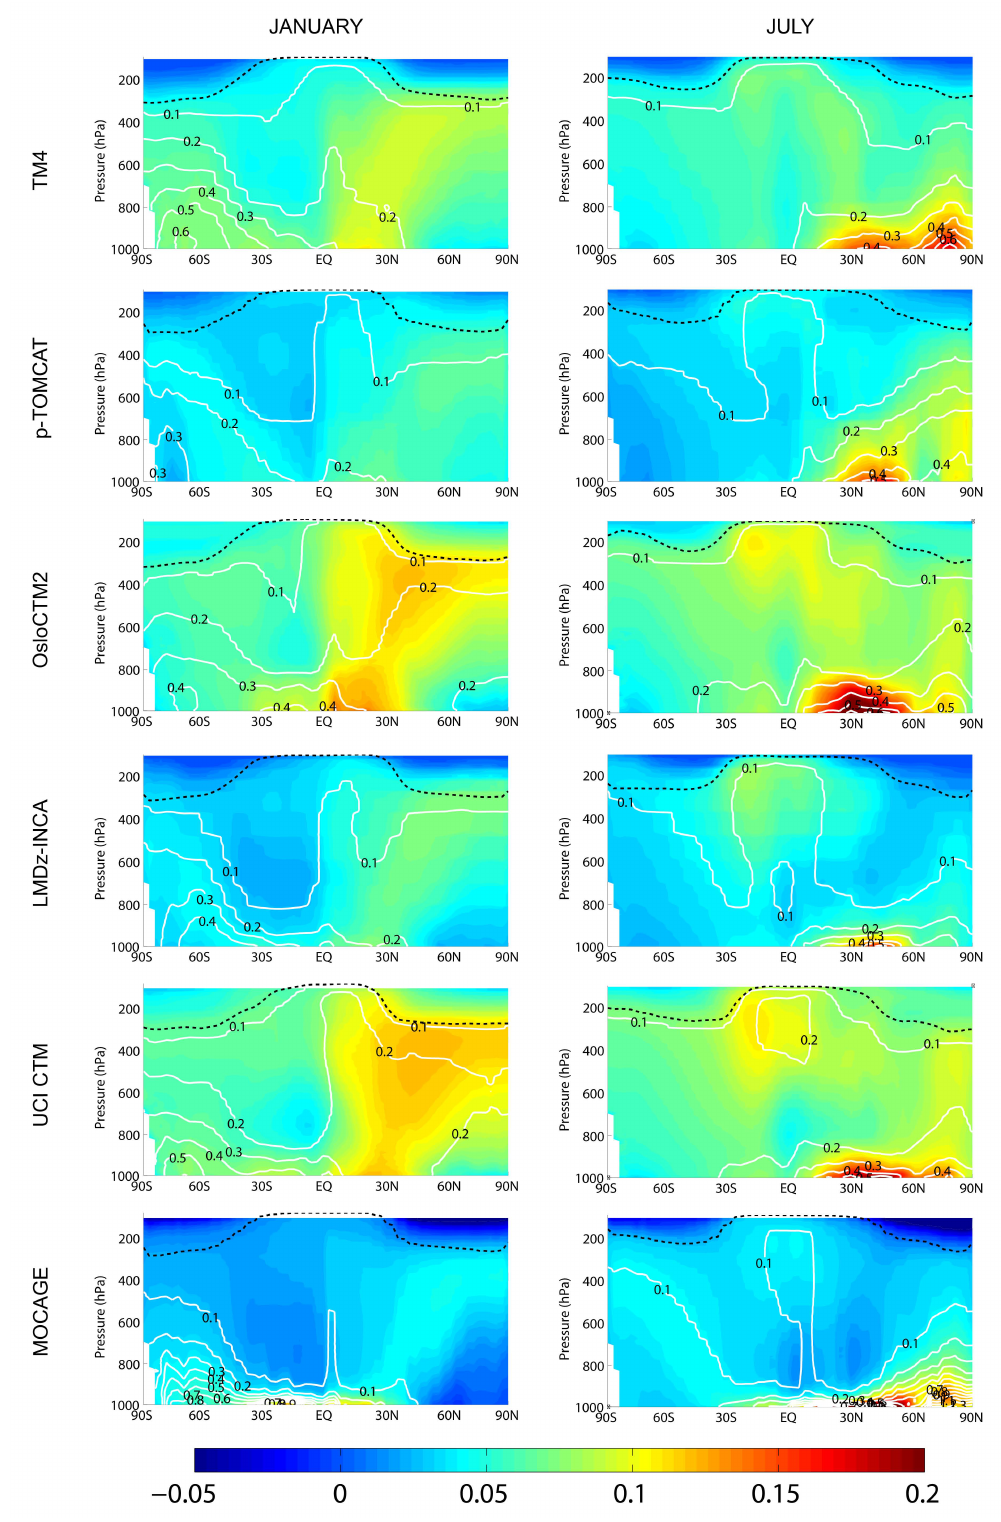
Fig. B2. Same as Fig. B1, but due to a 5% perturbation of ship emissions (BASE –